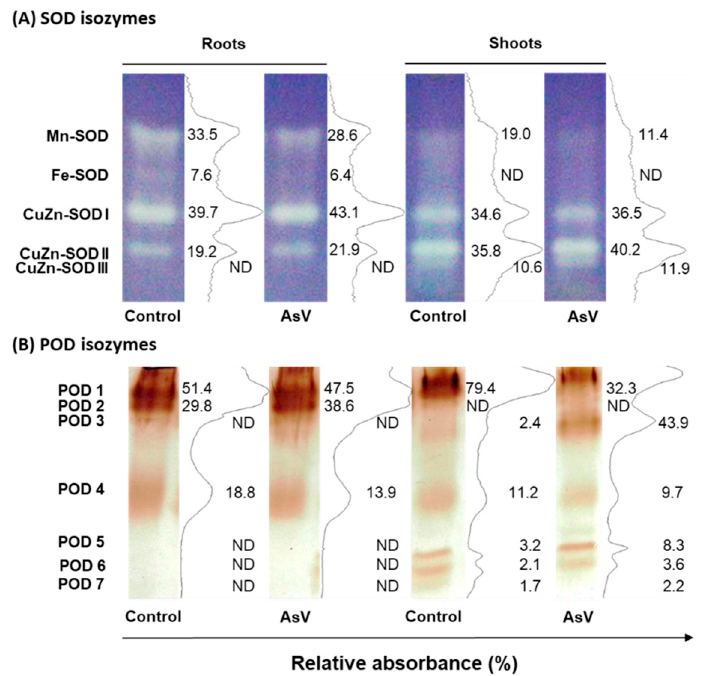
Figure 6. Superoxide (SOD) and peroxidase (POD) isoenzyme activity in roots and shoots of 26-d-old rice seedlings grown in hydroponic solutions supplemented the last 12 days without (control) and with 50 µ M AsV. ( A ) SOD. ( B ) POD. Isoenzymes were separated by nondenaturing PAGE in 10% (SOD) and 8% (POD) acrylamide gels. Then, the respective in-gel activity was detected by the NBT reduction method and the DAB oxidation method, respectively. Isozymes from both enzymatic systems are depicted on the left of each panel. Similar protein amount (80 µ g) per lane was loaded in each gel. For each isoenzyme profile, a representative picture, from at least three experiments, is shown. Relative quantification of band intensities was performed using the image analyzer software ImageJ.